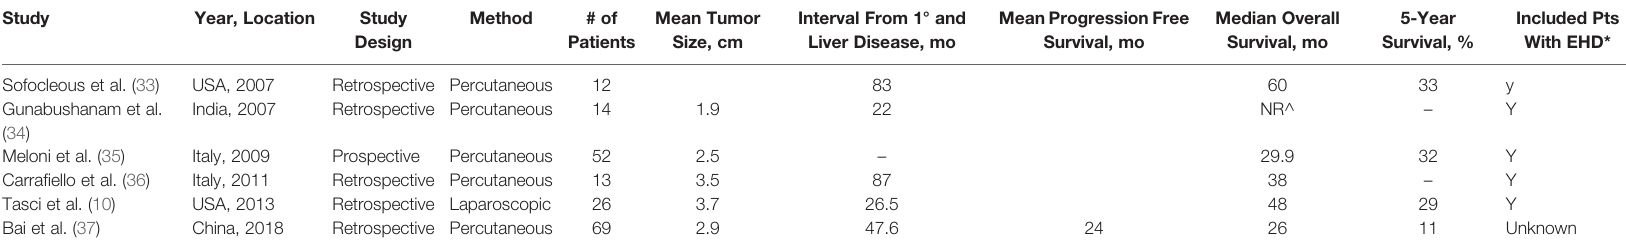
TABLE 3 | Radiofrequency Ablation.